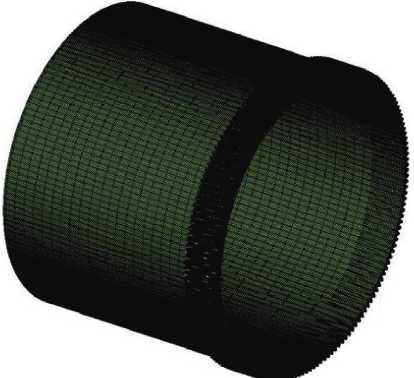
Figure 4: Finite element model of flexspline.